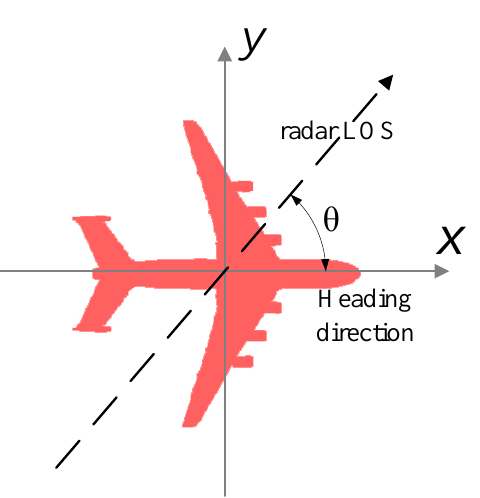
Figure 1. Definition of target aspect